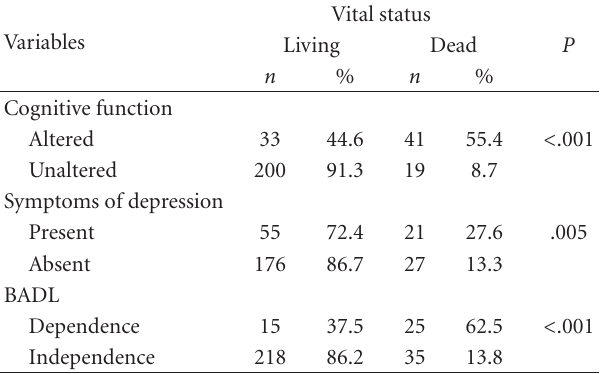
Table 3: Distribution of vital status, according to neuropsychiatric and functional capacity variables of elderly residents in Santa Cruz, Brazil.